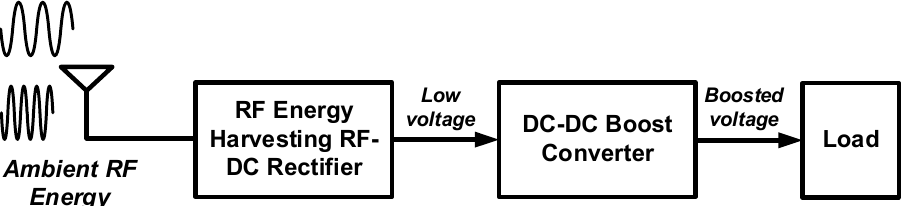
Figure 1. Block diagram of RF energy harvesting system consisting of RF energy harvesting RF-DC rectifier and DC-DC boost converter.